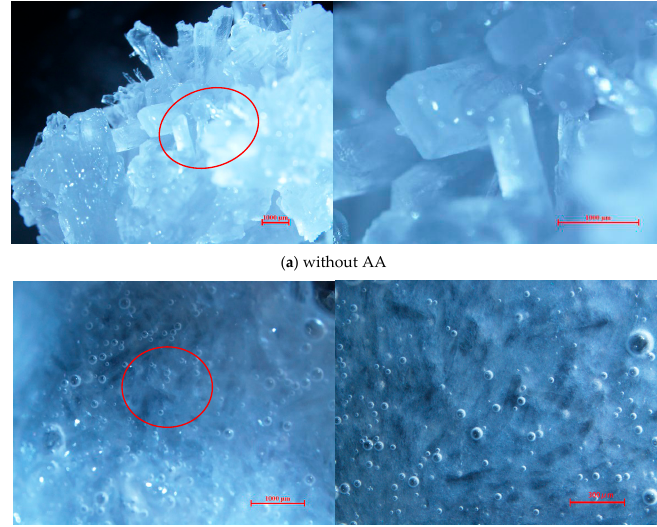
Figure 3. AA ′ s critical minimum concentration for different TBAB solutions.